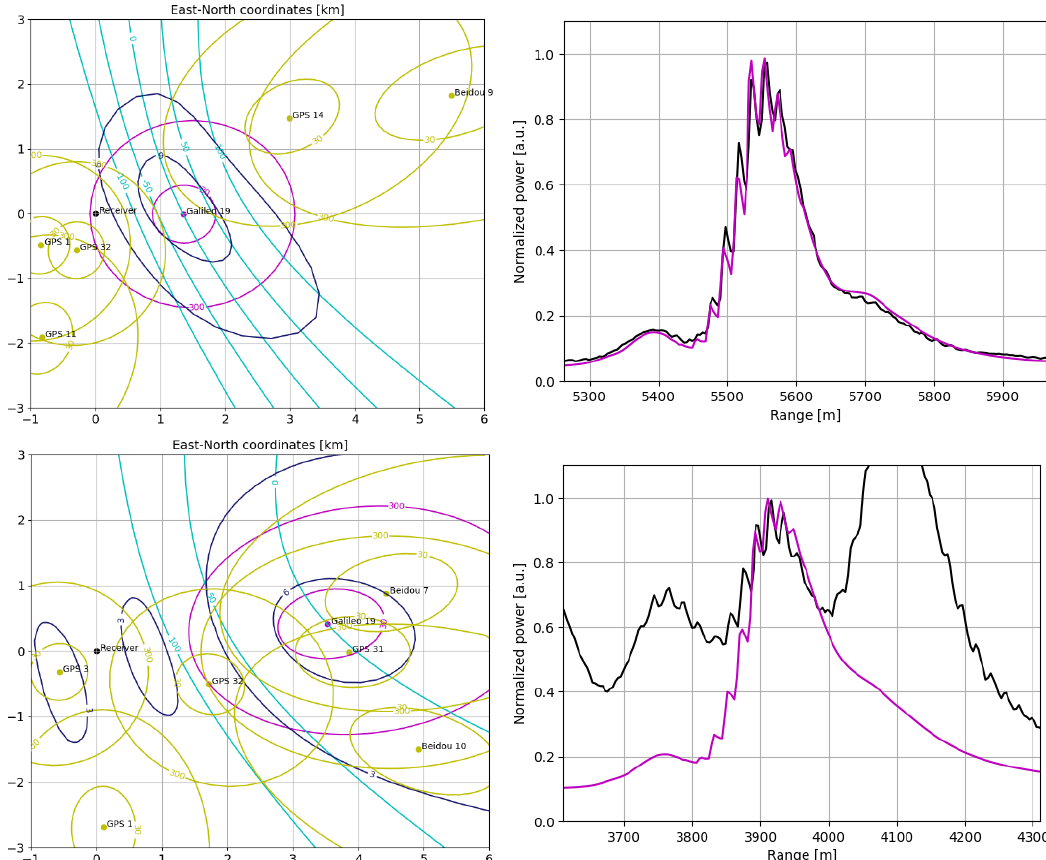
Figure 6. ( Up ) Clean example case for Galileo PRN19 at GPS second of the day (SoD) 39,200 (second #1070 in time from connected segments). ( Bottom ) Contaminated example case for Galileo PRN19 at GPS SoD 43,800 (second #4110 in time from connected segments). ( Left-side ) Simulated projection of iso-range (magenta color and meter units), iso-Doppler (cyan color and Hz units) and down-looking antenna array gain (dark blue color and dB units) contour lines over the sea surface for Galileo PRN19 (the origin is set to the vertical projection of the receiver’s location). The corresponding iso-range contours of additional GNSS signals in view are also plotted (yellow color and meter units). ( Right-side ) Normalized power waveform for data (black) and corresponding model assuming a single contribution from Galileo PRN19